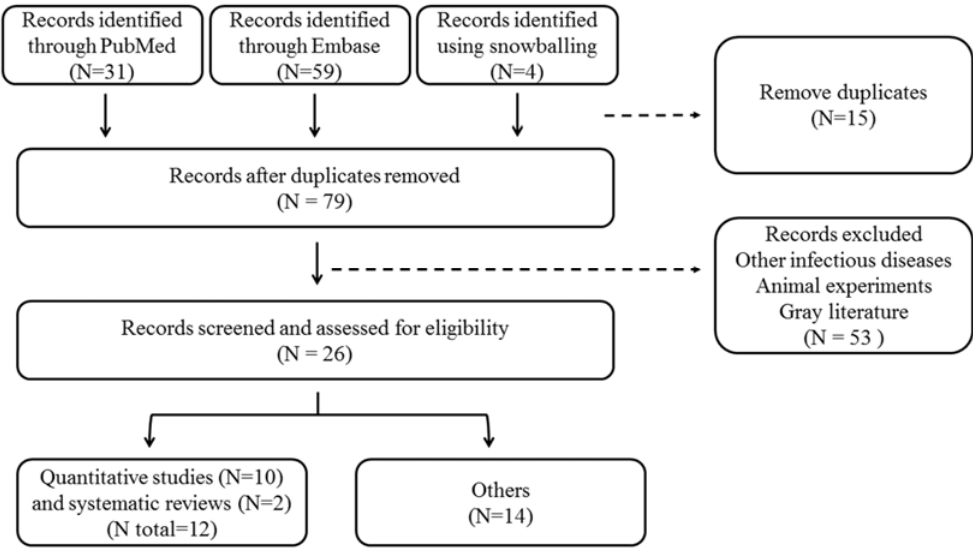
Figure 2. Flow chart for the literature review on chemoprophylaxis use for leptospirosis.